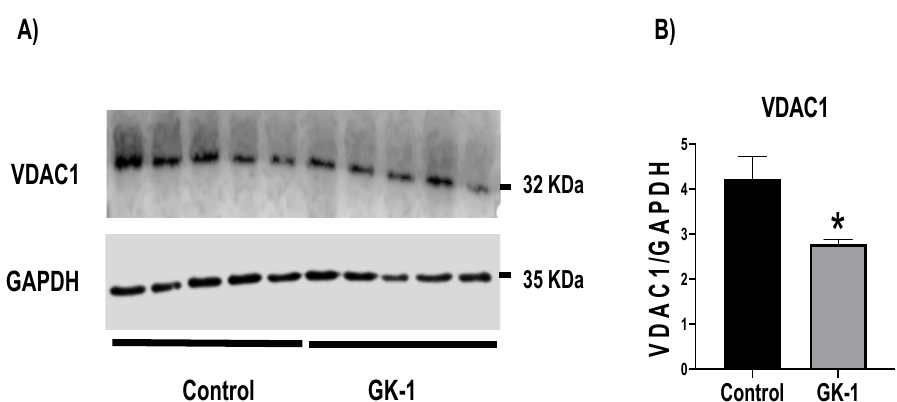
Figure 6. GK-1 decreases adenosine triphosphate (ATP) synthase. ( A ) Representative immunoblotting and ( B ) densitometric analysis of the levels of the ATP synthase-subunit (ATP5A), ( C ) cytochrome c oxidase subunit I (CIV-MTCO1), ( D ) ubiquinol–cytochrome c reductase core protein 2 (CIII-UQCRC2), ( E ) succinate dehydrogenase complex iron sulfur subunit B (CII-SDHB) and ( F ) reduced form of nicotinamide adenine dinucleotide ubiquinone oxidoreductase subunit B8 (CI-NDUFB8) in tumors treated with GK-1 and saline solution (control). Glyceraldehyde 3-phosphate dehydrogenase (GAPDH) was used as the loading control. t -Student test, control vs. GK-1, ** p < 0.005. Data are expressed as mean ± SEM, n = 5.